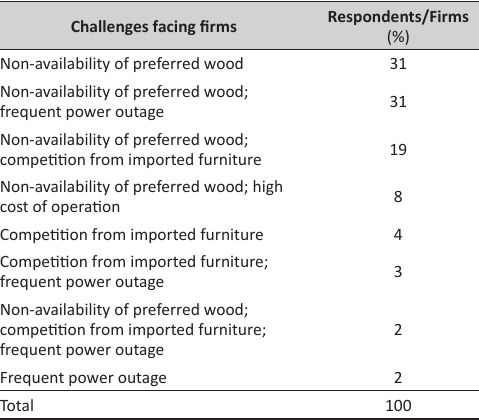
TaBLe 5. Challenges faced by firms in furniture